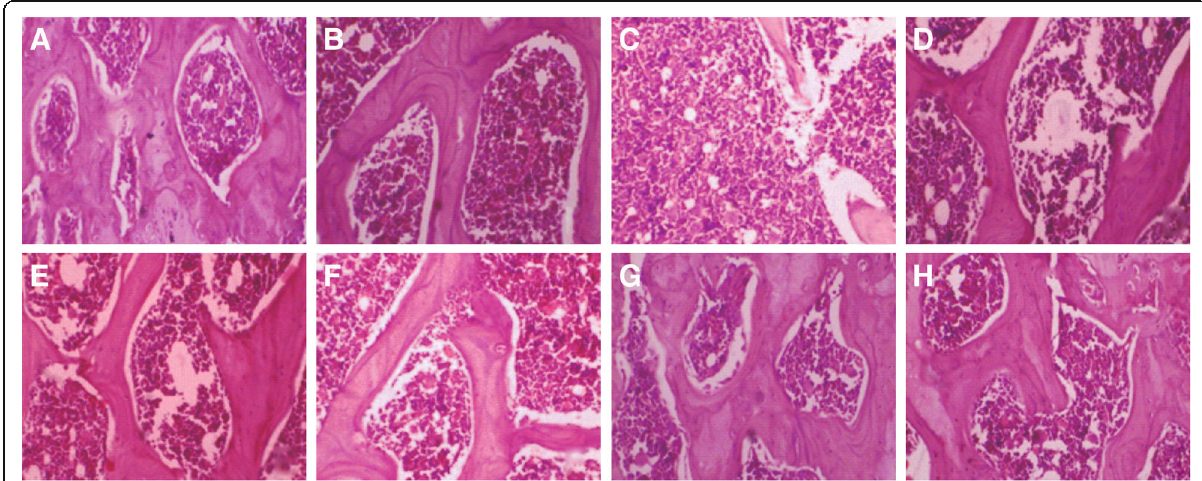
Fig. 7 Effect of plant extracts of B. ceiba on histopathological parameters of rat femur; a and b : NC and Sham, Longitudinal section of femur of normal control group and sham control showing compact, normal and uniform trabecular bone; c : OVX, OVX group showed widely separated and thin bone trabeculae, loss of interconnectivity and widening of bone marrow spaces; d and e : PE100 and PE200, Petroleum ether extract (100 and 200 mg/kg) of B. ceiba showed less separated bone trabeculae, formation with reduced interconnectivity, narrowing of intertrabecular space; f and g :ME100 and ME200, Methanolic extract (100 and 200 mg/kg) of B. ceiba showed compact, normal, thick and uniform bone trabeculae, interconnectivity between bone trabeculae, narrowing of bone marrow spaces; h : Std Ralox, Standard drug: Raloxifene (1 mg/kg) showed thickening of trabecular bone and restoration of normal architecture of bone